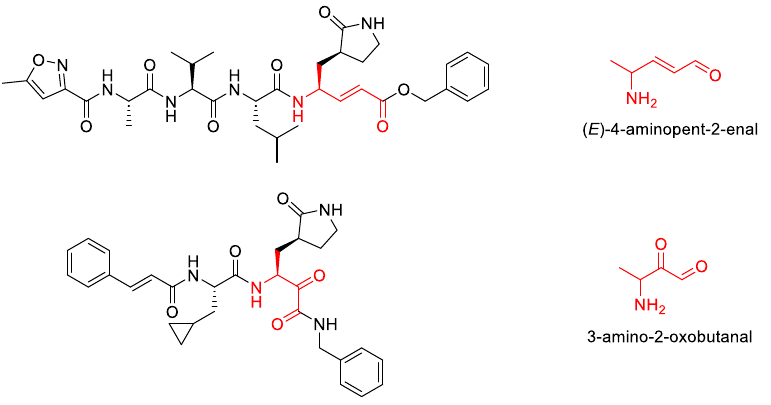
Figure 9. Structure of the chosen cores.